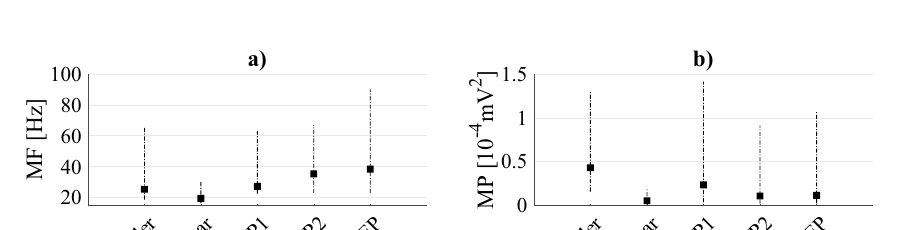
Figure 3. Median relative power contents in the different sub-bands for each EGM type. Median values of relative power contents obtained in the different spectral ranges are reported for Border (black bars), Scar (darker grey bars), LP1 (middle grey bars), LP2 (lighter grey bars) and EP (white bars) EGMs. A zoom on the upper sub-bands (i.e., from 80 to 320 Hz) is also provided to allow for a better visualization of the relative power contributions at the higher frequencies. The legend graphically details the association between colours and the different EGM types.